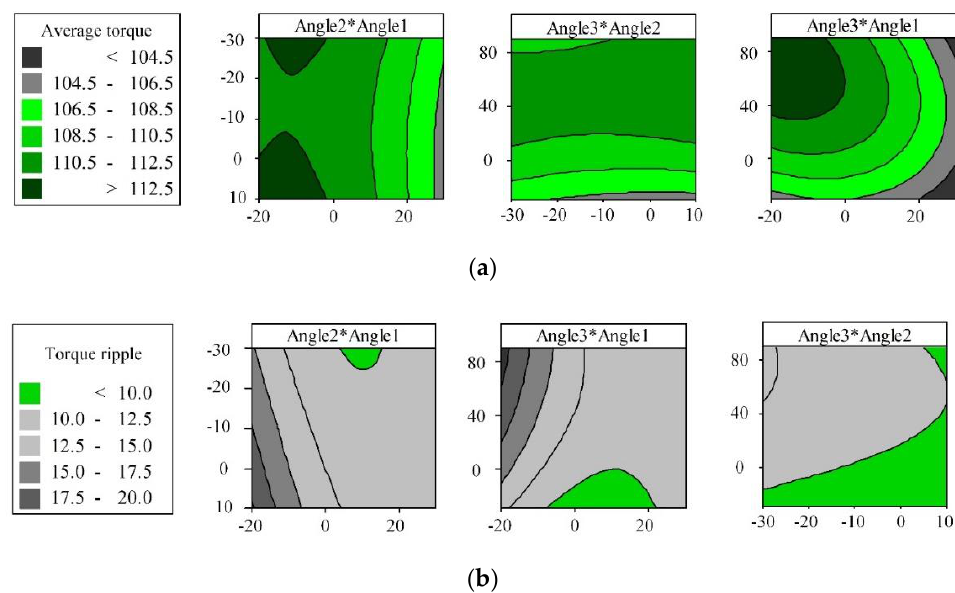
Figure 7. Contour plot according to design parameters by 2D finite element analysis (FEA) result: ( a ) average torque; ( b ) torque ripple.